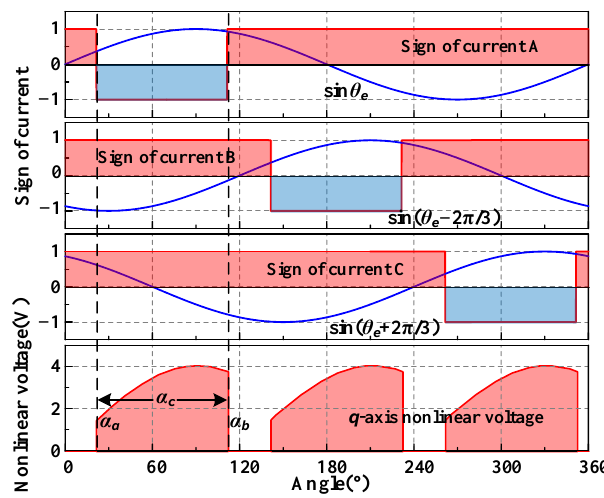
Figure 5. Diagram of q -axis nonlinear voltage.